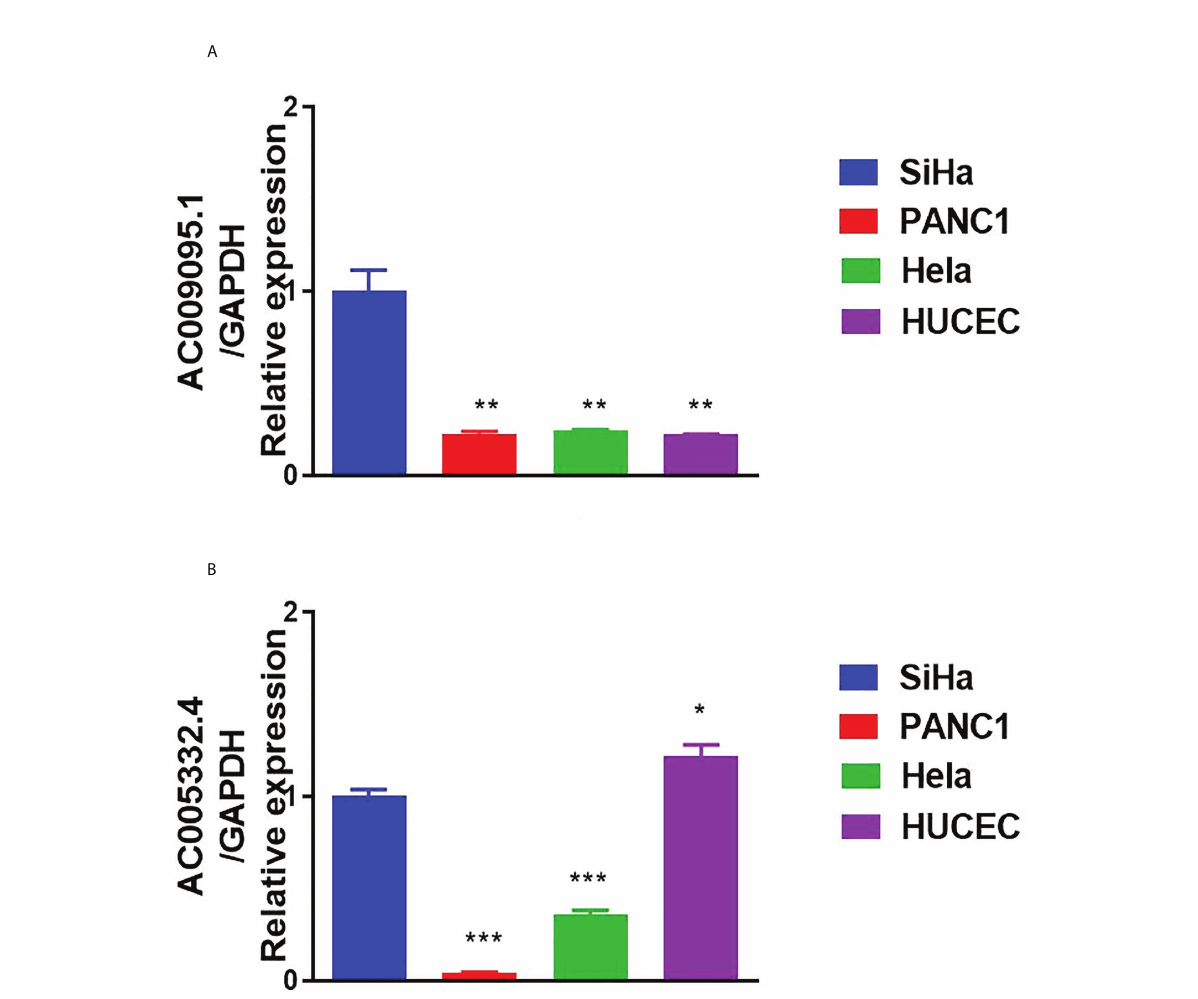
FIGURE 11 Results of qRT-PCR. (A) The expression of AC009095.1 in the four cell lines and AC009095.1 expression were signi fi cantly higher in SiHa cell lines than in the other three cell lines. (B) The expression of AC005332.4 in the four cell lines and AC005332.4 expression were higher in SiHa cell lines than in PANC-1 and Hela cell lines but were slightly lower than in HUCEC cell lines. *p < 0.05, **p < 0.01, ***p <